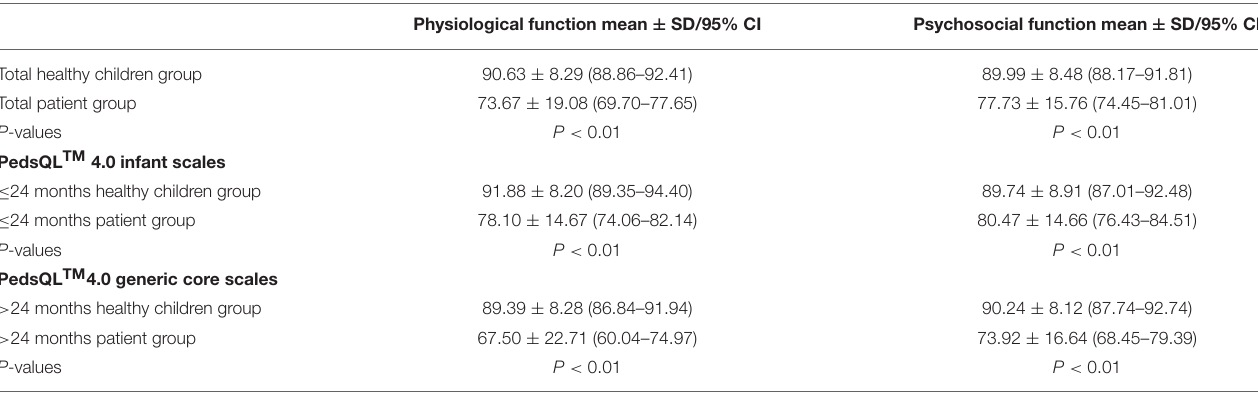
TABLE 4 | Scores of physiological and psychosocial functions in children with KHE and normal